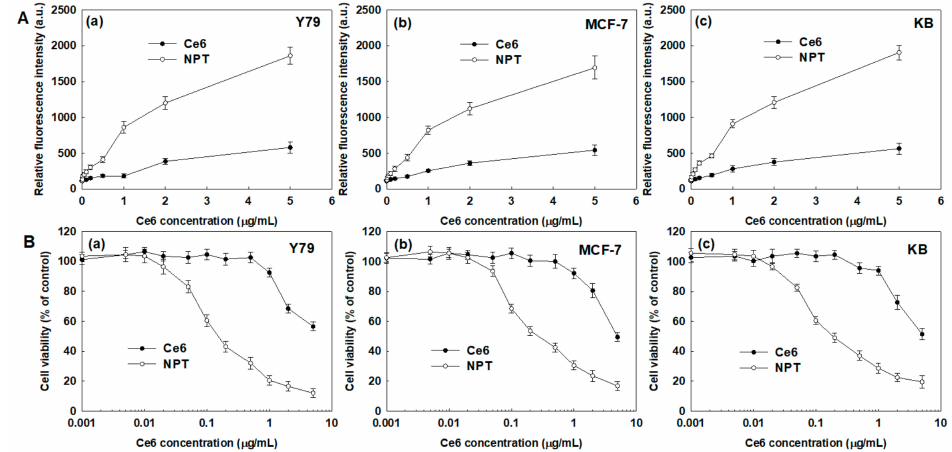
Figure 7. The effect of free Ce6 or nanophotosensitizers on ROS generation ( A ) and phototoxicity ( B ) against various cancer cells. ( A ). ( a ) Y79 cells, ( b ) MCF-7 cells and ( c ) KB cells. ( B ). ( a ) Y79 cells, ( b ) MCF-7 cells and ( c ) KB cells. DCFH-DA assay was employed to measure intracellular ROS level. Cells were irradiated at 664 nm (2 J/cm 2 ). All values are average ± S.D. from results of a single independent experiment with eight